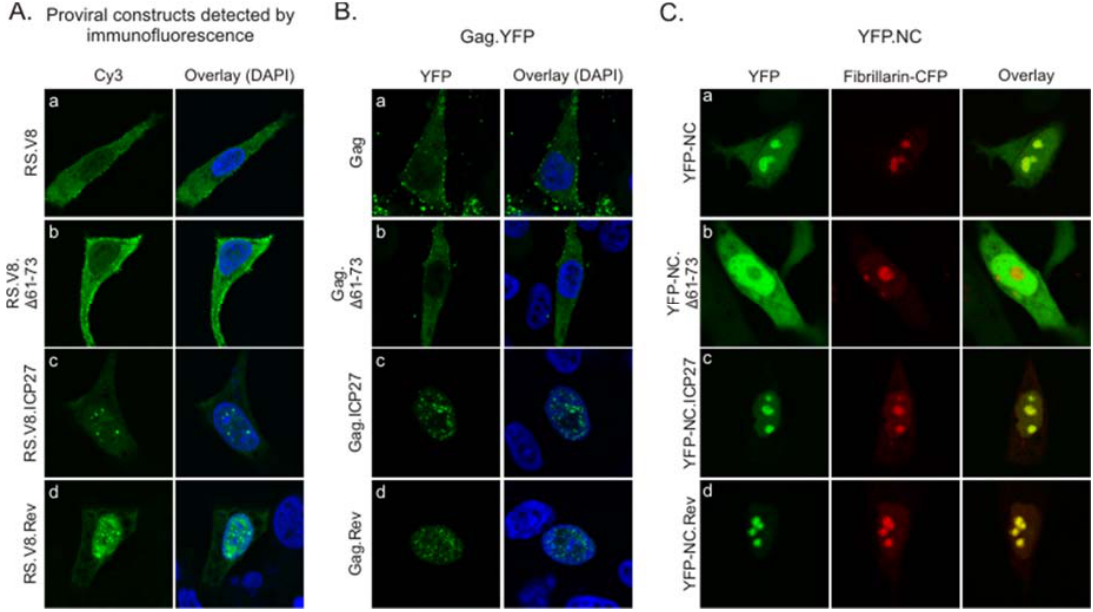
Figure 2. Subcellular localization of Gag ICP27 BR and Rev BR substitution mutants. ( A ) QT6 cells expressing wild-type or mutant proviral constructs were immunostained with anti-RSV antibodies 16 h after transfection to detect localization of Gag. Confocal microscopy images taken through the central plane of the nucleus show the distribution of wild-type Gag (panel a), Gag. ∆ 61-73 (panel b), Gag.ICP27 (panel c), and Gag.Rev (panel d). ( B ) Plasmids encoding wild-type (panel a) and mutant Gag.YFP proteins (panels b–d) were expressed in QT6 cells and fluorescence was detected using confocal microscopy. ( C ) QT6 cells were co-transfected with wild-type YFP-NC (panel a; green) or mutant YFP-NC proteins (panels b–d; green) and fibrillarin-CFP (red) as a marker for nucleoli, with the overlay images showing colocalization